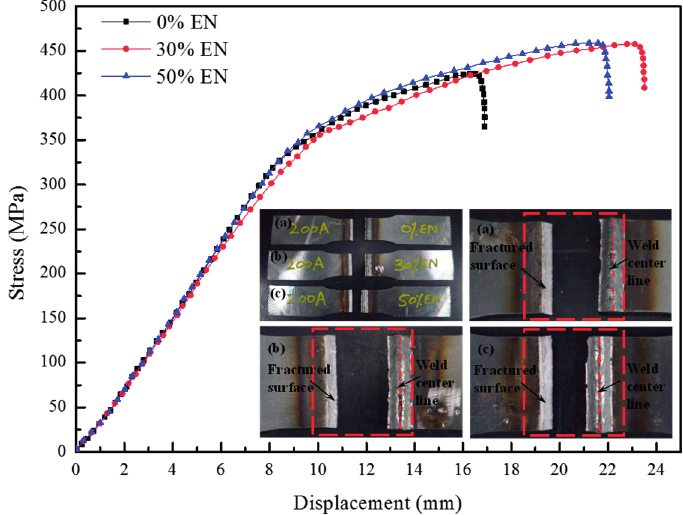
Figure 14. Stress vs. displacement at Ia of 200 A. The inset shows the fractured surfaces of the tested